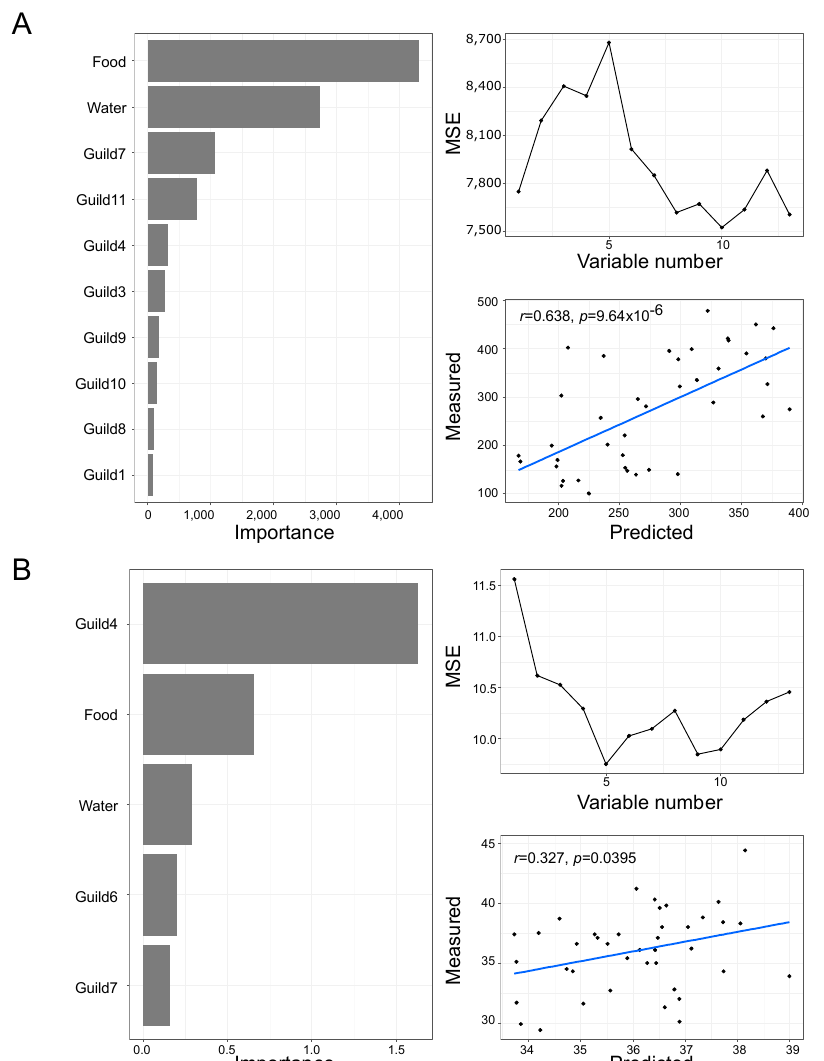
Figure 5. The association between gut microbiota, food and water consumption and host phenotype. ( A ) blood glucose. ( B ) body weight. Random Forest (RF) model was used to regress the blood glucose level/body weight on the guild abundance, food consumption and water consumption on Day 28. The bar charts: the RF assigns a mean error rate, or feature-importance score to each feature; this value indicates the extent to which each predictor contributes to the accuracy of the model. The curves show the number of variables and mean squared error of the corresponding model. Scatter plots of the measured values and the predicted values from leave-one-out cross-validation. Pearson correlation was applied.